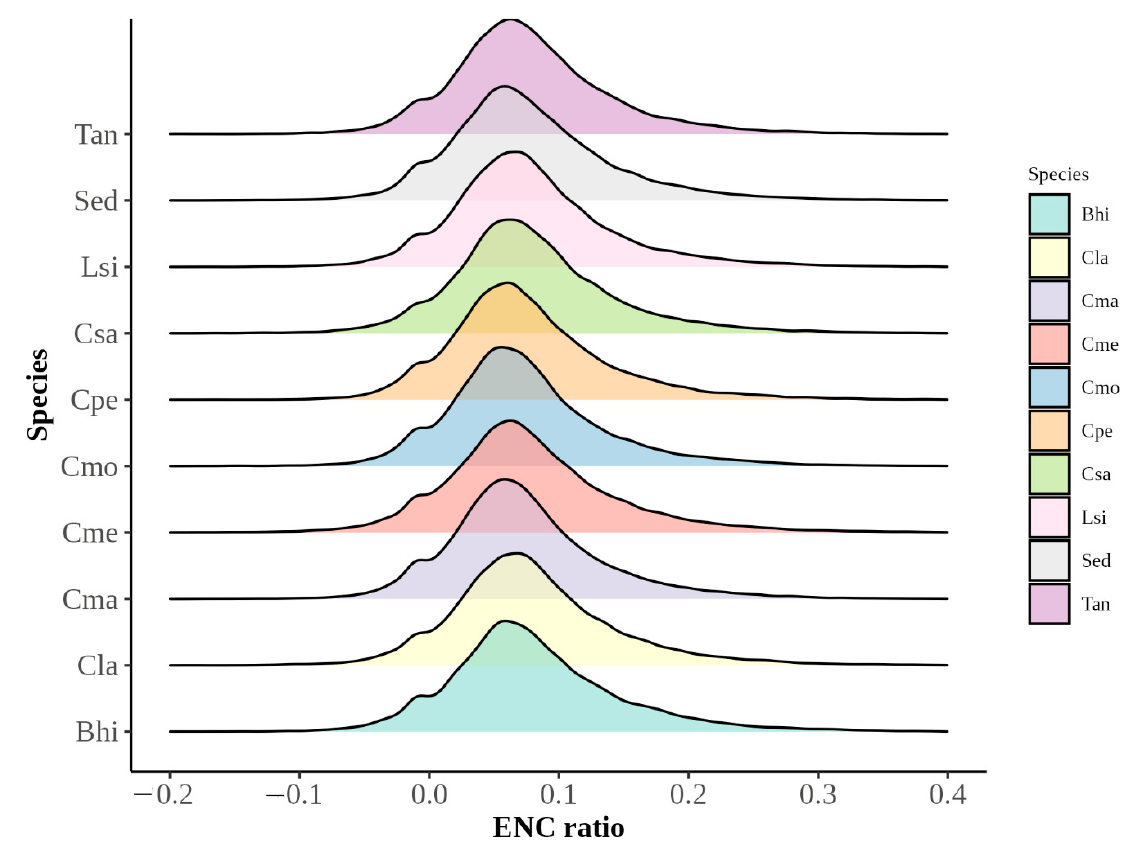
Figure 7. Distribution of ENC ratio in ten species of Cucurbitaceae. Note: the horizontal axis is the value of ENC ratio ((ENCexp − ENCobs)/ENCexp); the vertical axis indicates each species. Abbreviations are used for species names (refer to Table 1 for details).